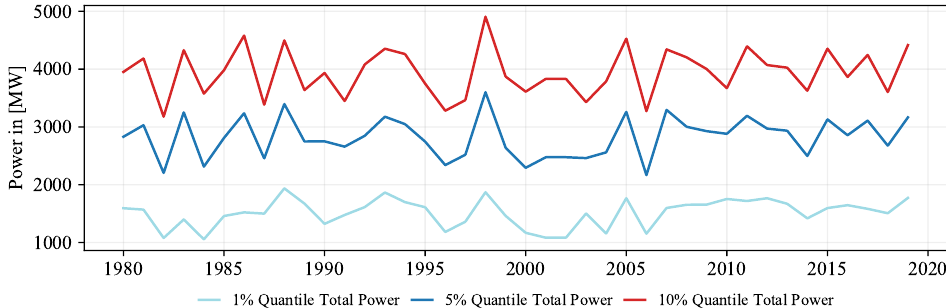
Figure 12. The 1%, 5%, and 10% quantiles of total power production from 1980 to 2019. Every line illustrates a quantile over the years derived from the yearly CDF of total power generation analogously to the CDF shown in Figure 11 for